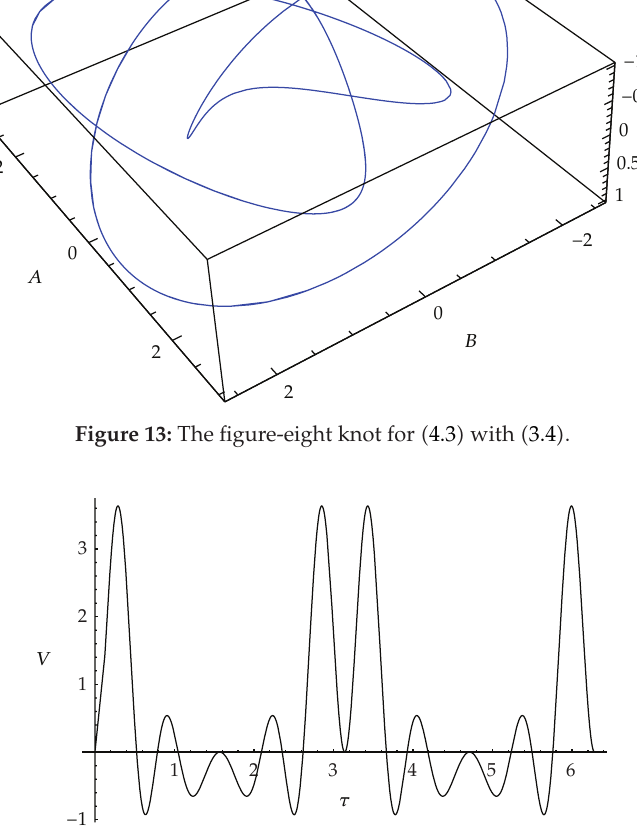
Figure 14: The evolution of the volume for the solution (cid:2) 4.3 (cid:3) with (cid:2) 3.4 (cid:3) , t ∈ (cid:4) 0 , 2 π (cid:5)